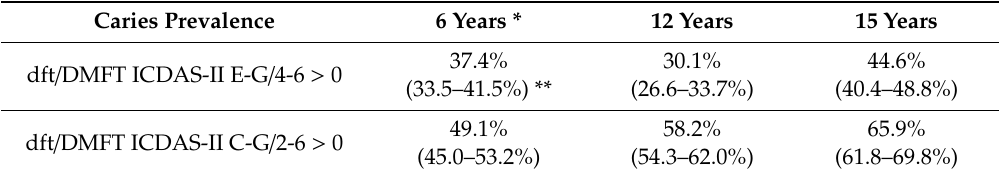
Table 1. Caries prevalence in the three age